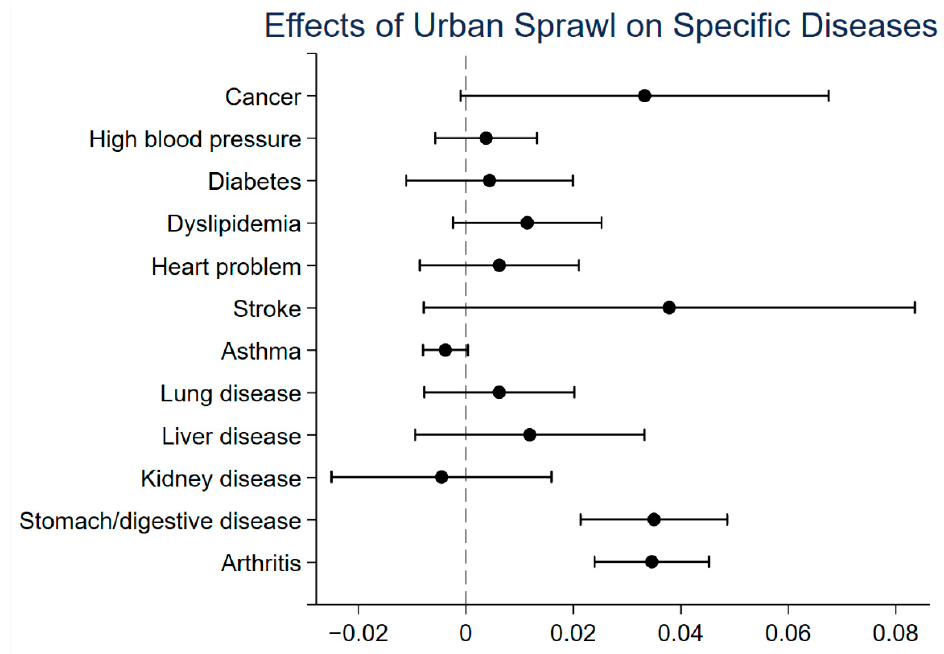
Figure 1. Coefficients and 90% confidence intervals of regressions for each specific disease.